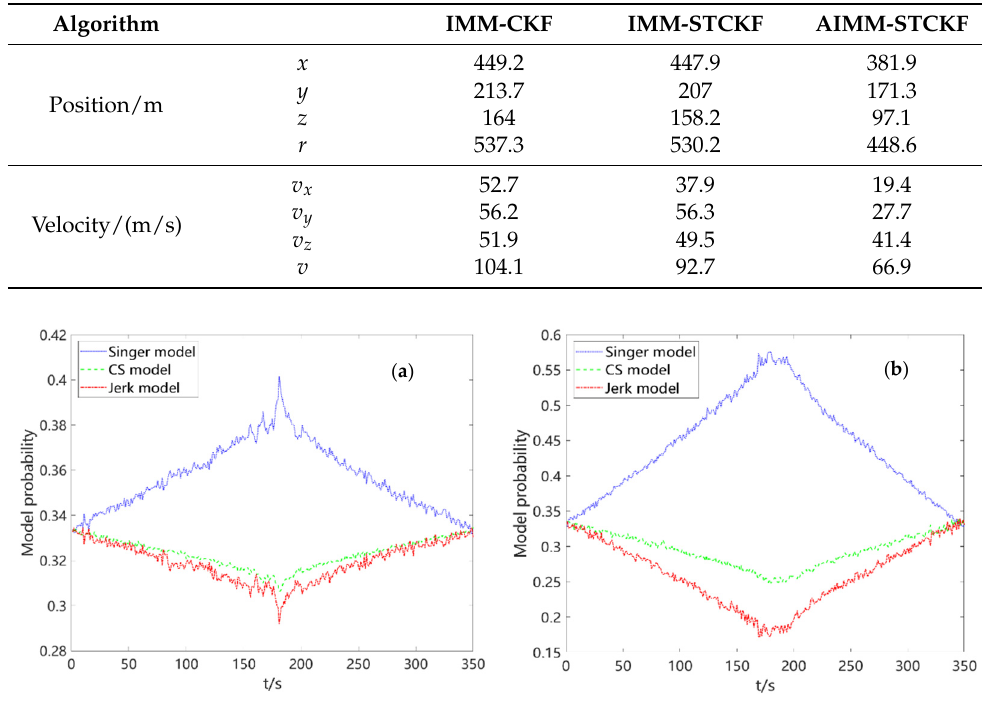
Figure 12. Model probability: ( a ) IMM-CKF; ( b ) AIMM-STCKF.